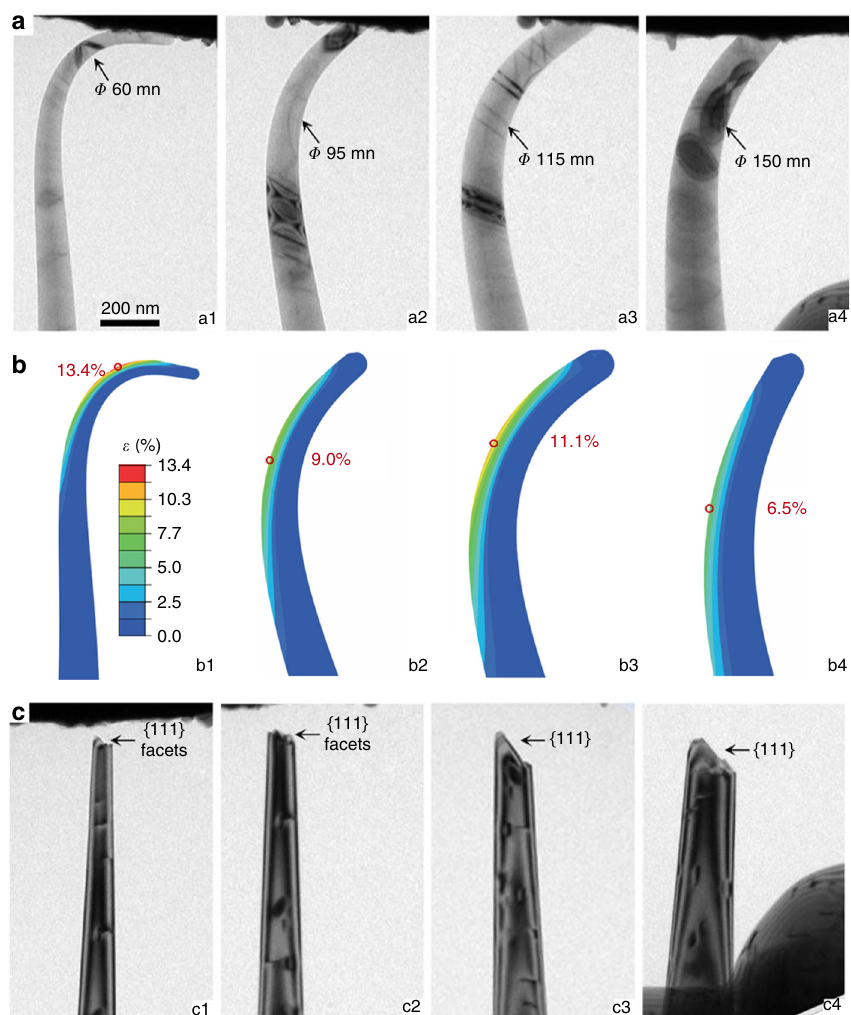
Fig. 3 A sequence of breaking tests on a single <100> - diamond nanoneedle. Arrows indicate locations of fractures in subsequent breaking tests. a Snapshots (a1 – a4) capturing the maximum deformation immediately before the fracture during sequentially breaking the diamond nanoneedle for its high aspect ratio geometry. For more details, see Supplementary Movie 4. b FEM simulations reproducing the critical needle geometry immediately prior to breaking in a and with maximum principle strain distribution in the nanoneedle. c TEM images of the needle after the corresponding breaking tests, revealing that all fracture surfaces consist of {111}